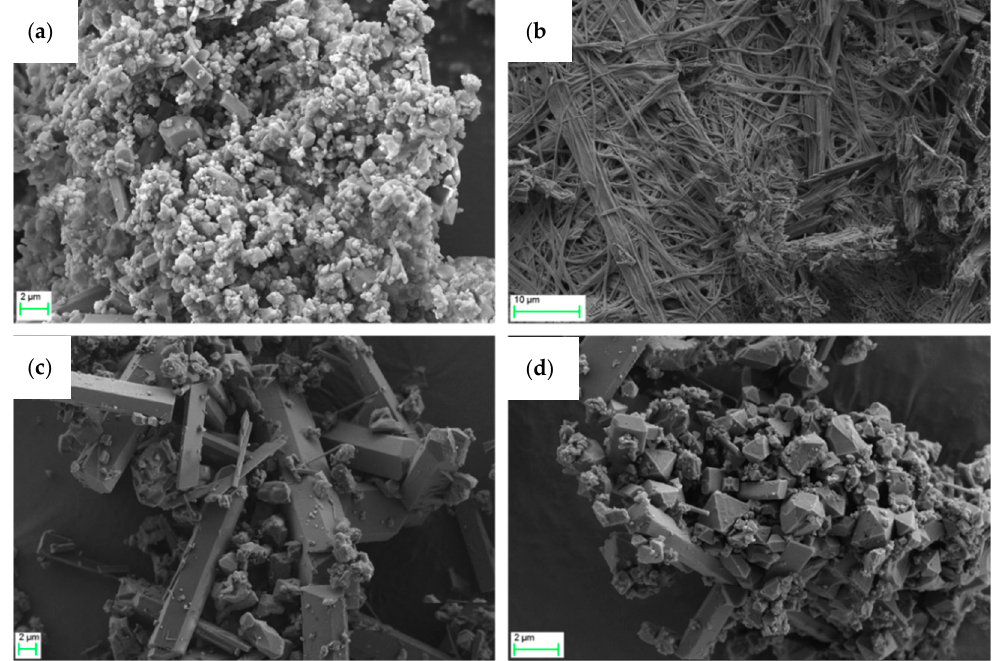
Figure 5. SEM images of the products formed at ( a ) 0.78 M H 3 BTC solution at room temperature using 0.250 Hz frequency compared to ( b ) a higher H 3 BTC concentration of 0.300 M, ( c ) a higher temperature of 60 °C, and ( d ) a lower frequency of 0.05 Hz.